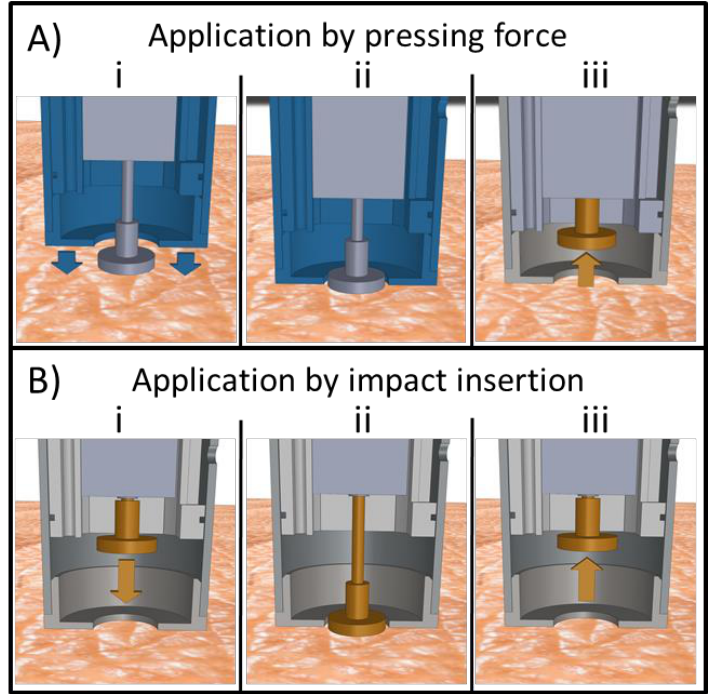
Figure 3. Application of microneedles onto skin by ( A ) pressing force: ( i ) electromagnetic actuator in the extended position, ( ii ) microneedle mount pressed onto the skin by hand force, ( iii ) microneedle mount retracted into the applicator; ( B ) impact insertion: ( i ) electromagnetic actuator in its retracted position, ( ii ) microneedle mount propelled into extended position, ( iii ) microneedle mount retracted into the applicator (see main text for explanation).